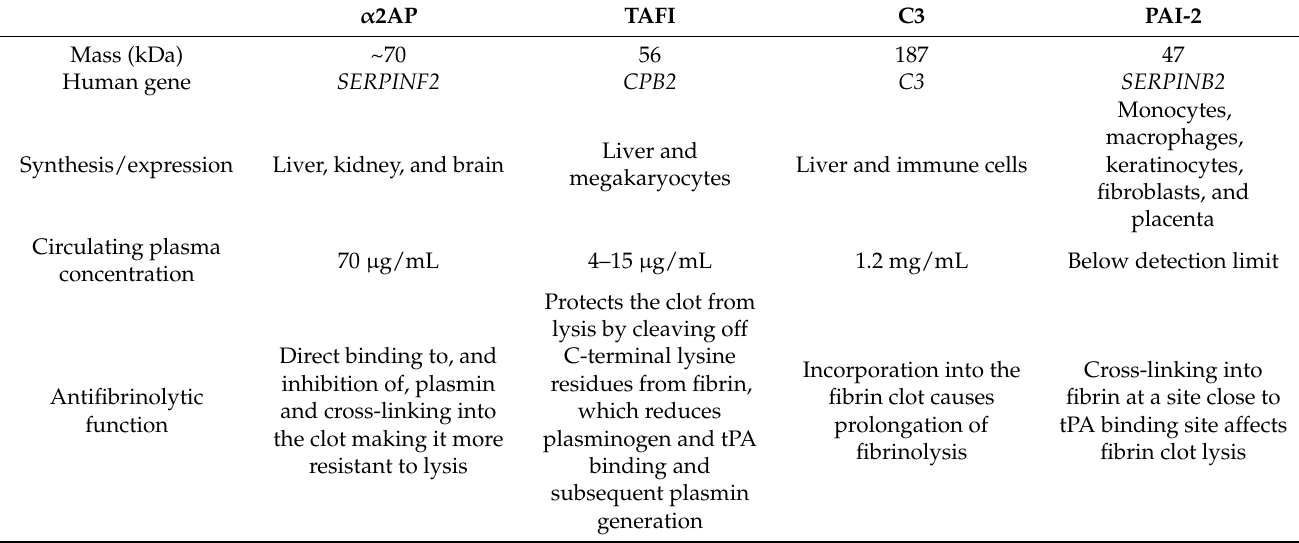
Table 1. Summary of fibrin-bound antifibrinolytic proteins alpha-2 antiplasmin ( α 2AP), thrombin activatable fibrinolysis inhibitor (TAFI), complement C3, and plasminogen activator inhibitor-2